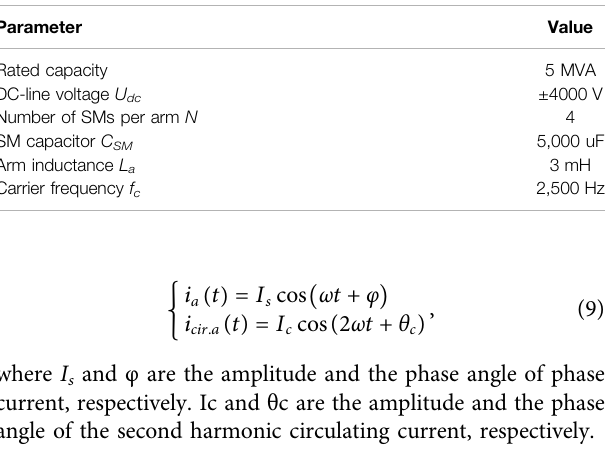
TABLE 2 | Parameters of the MMC